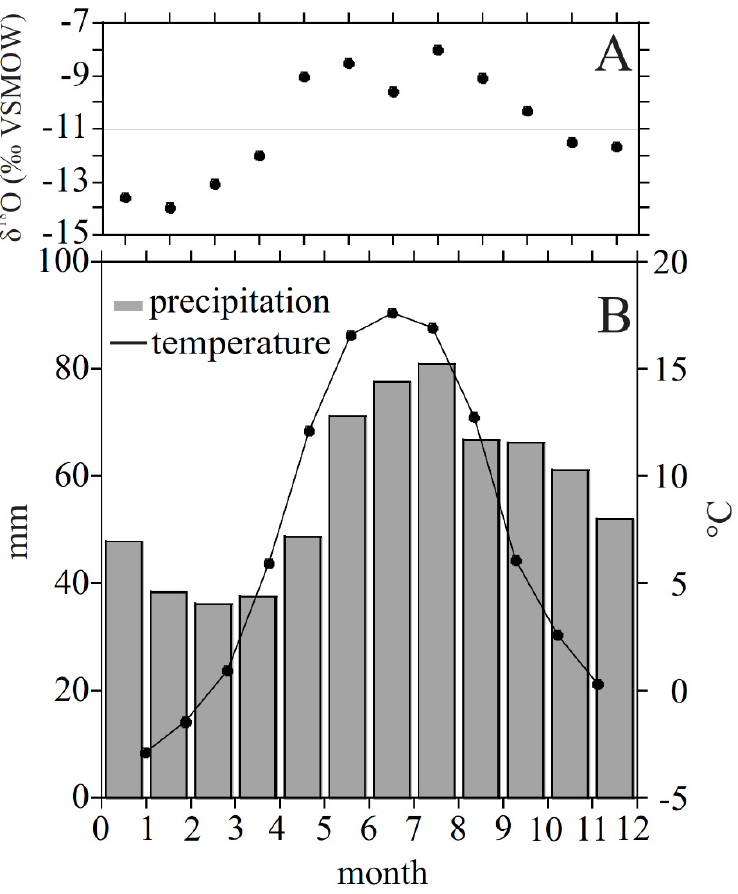
Figure 3. Panel ( A ): Estonia Global Network of Isotopes in Precipitation (GNIP) precipitation- weighted δ 18 O p data for Tartu shown with average monthly values for 2014 through 2018, with the annual mean shown with a gray solid line. Panel ( B ): Monthly precipitation and temperature values at Valga, Estonia for the period spanning 1945 to 2020 (Estonian Weather Service).